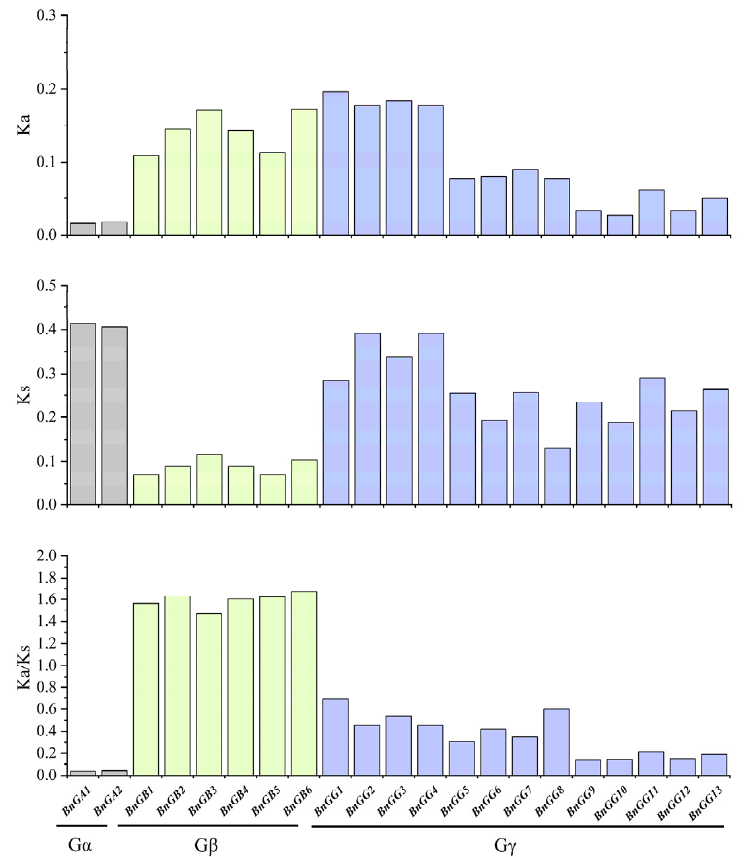
Figure 5. Nonsynonymous rate (Ka), synonymous rate (Ks), and evolutionary constraint (Ka/Ks) ratio between A. thaliana G-proteins and the corresponding orthologs in B. napus. Gray, green and purple represents G α subunit genes, G β subunit genes, and G γ subunit genes, respectively.